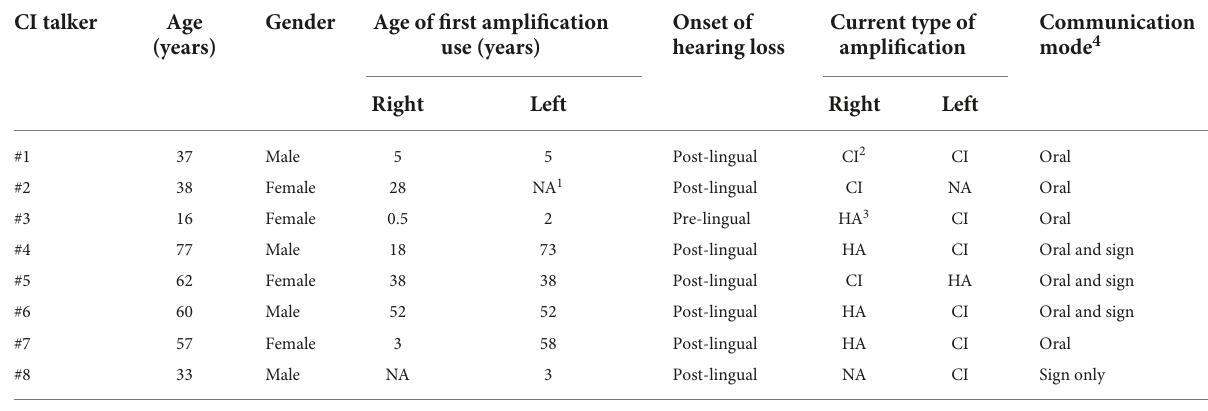
TABLE 2 Demographic details of the CI talkers from the deaf speech corpus.